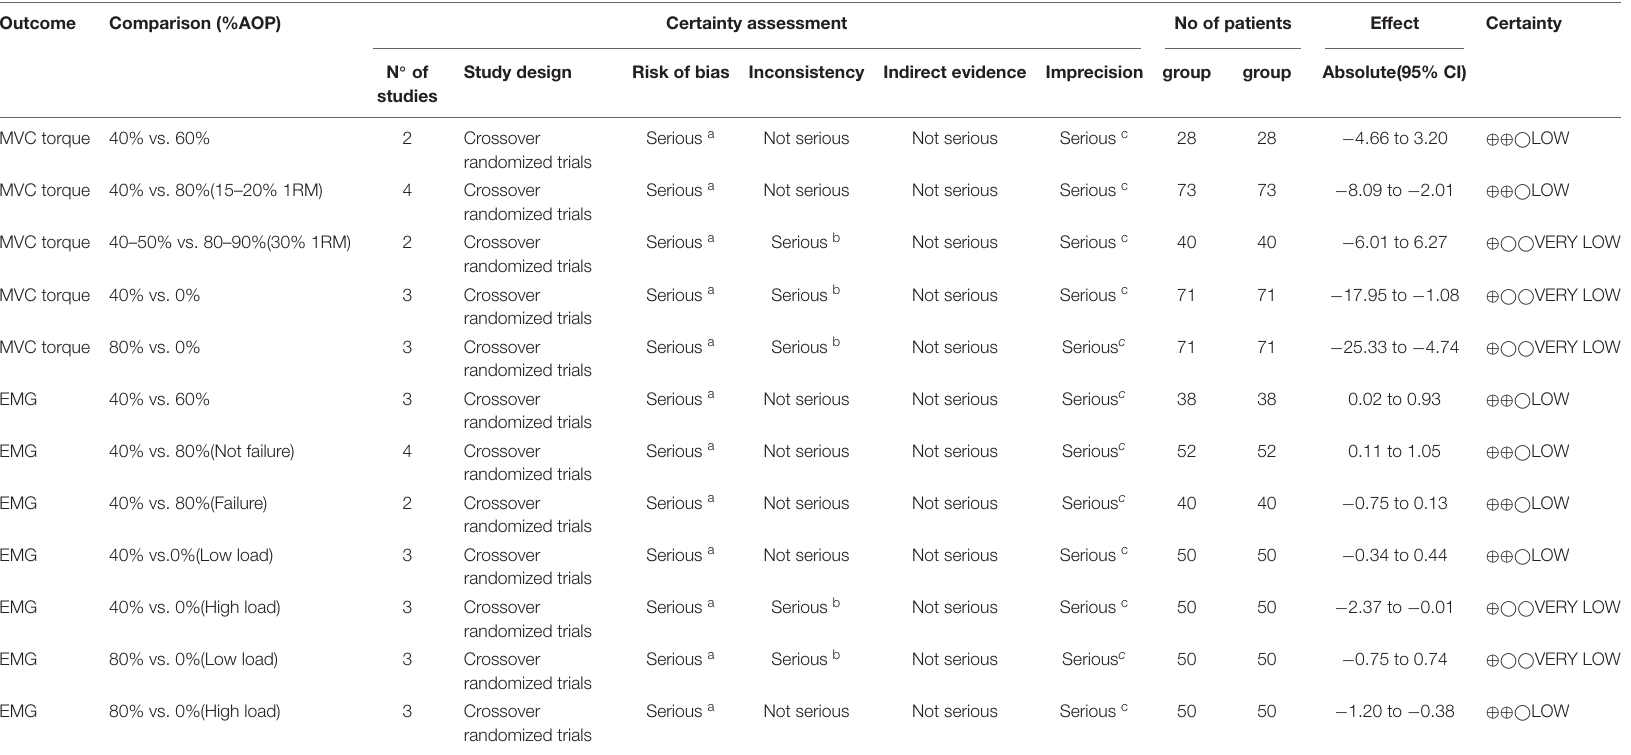
TABLE 4 | Certainty of evidence according to the GRADE. Outcome